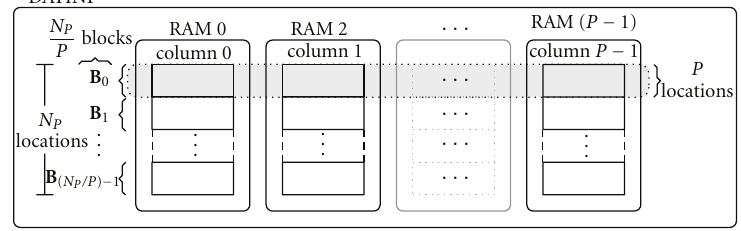
Figure 9: Data block organization in the DATINF.